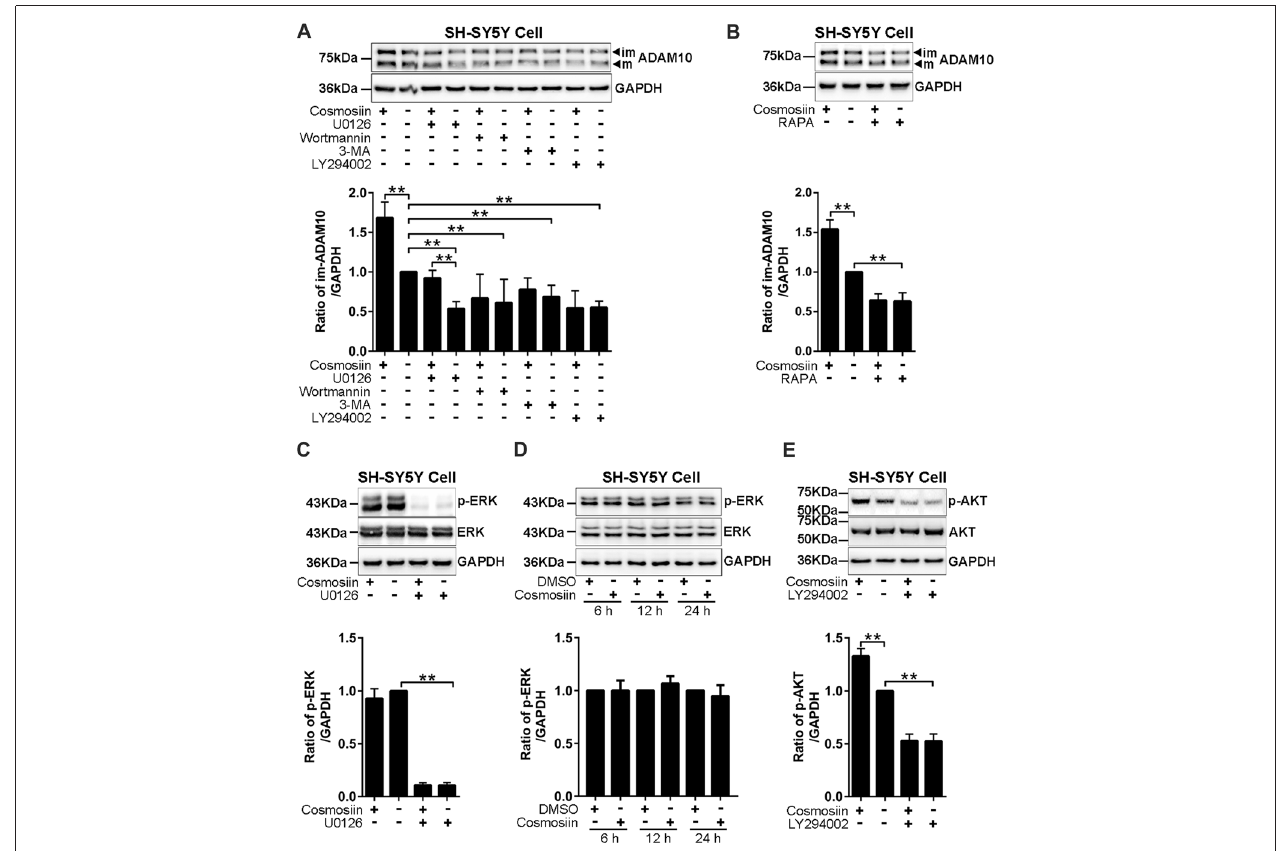
FIGURE 4 | Phosphatidylinositide 3-kinase (PI3K) signaling is involved in cosmosiin regulation of ADAM10. (A) Representative Western blots (top) and bar plot summary (bottom) of ADAM10 levels in SH-SY5Y cells treated with cosmosiin (5 µ M) for 36 h and pre-incubated for 1 h with: ERK inhibitor U0126 (20 µ M); PI3K inhibitors LY294002 (10 µ M), wortmannin (0.1 µ M), or 3-MA (50 µ M). (B) Representative Western blots (top) and bar plot summary (bottom) of ADAM10 levels in SH-SY5Y cells treated with cosmosiin (5 µ M) for 36 h and pre-incubated for 1 h with mTOR inhibitor rapamycin (RAPA, 5 µ M). (C) Representative Western blots (top) and bar plot summary (bottom) of ERK and phosphorylated ERK (p-ERK) levels in SH-SY5Y cells in the absence or presence of cosmosiin (5 µ M) or U0126 (20 µ M) for 36 h. (D) Representative Western blots (top) and bar plot summary (bottom) of ERK and phosphorylated ERK (p-ERK) in SH-SY5Y cells treated with the vehicle DMSO (1:10,000) or 5 µ M cosmosiin for indicated times (6, 12 and 24 h). (E) Representative Western blots (top) and bar plot summary (bottom) of AKT and phosphorylated AKT (p-AKT) in SH-SY5Y cells in the absence or presence of cosmosiin (5 µ M) or LY294002 (10 µ M) for 36 h. Data are expressed as means ± SD. ∗ P < 0.05; ∗∗ P < 0.01 ( n =